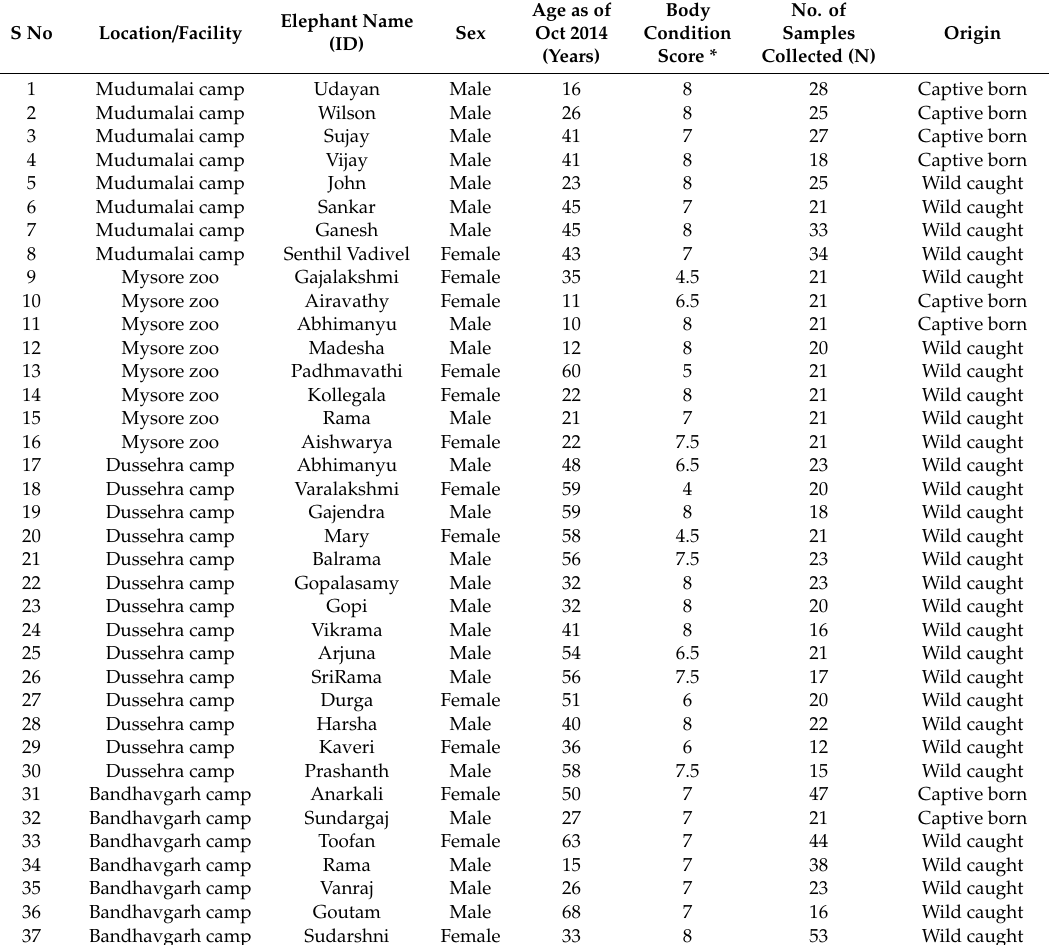
Table 1. Details of Facility, ID, body condition, age, sex, number of samples collected, and origin of captive Asian